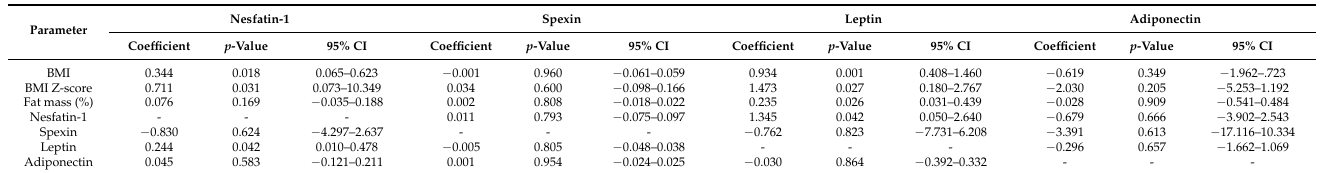
Table 4. Associations between peptides regulating appetite and selected anthropometric parameters in the entire group of children with